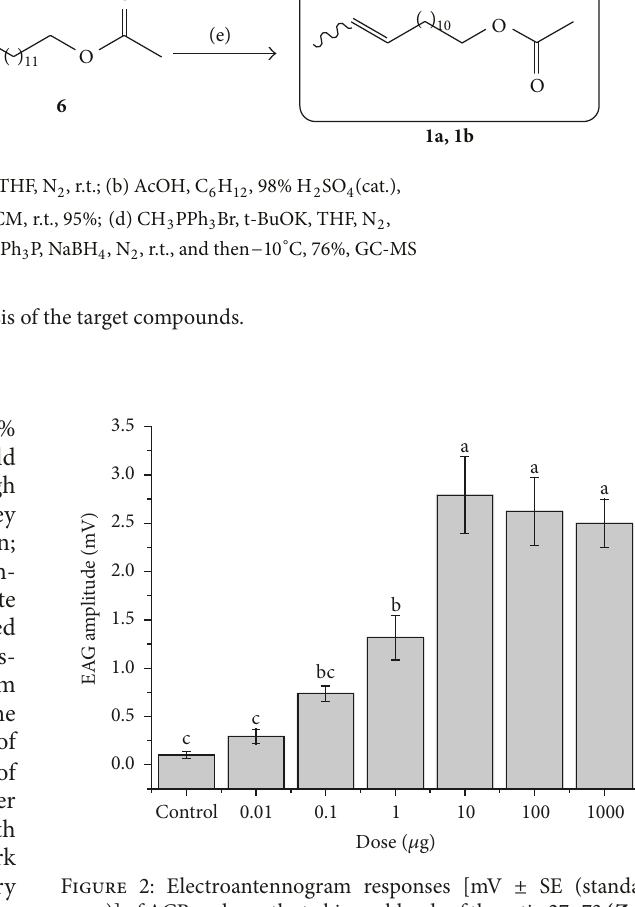
Figure 2: Electroantennogram responses [mV ± SE (standard error)] of ACB male moths to binary blends of the ratio 27: 73 ( Z : E ) in different doses. Male moths treated with 1 𝜇 L of redistilled hexane were used as control. Bars with the same letter are not significantly different (ANOVA and Tukey’s HSD, 𝑝 < 0.05